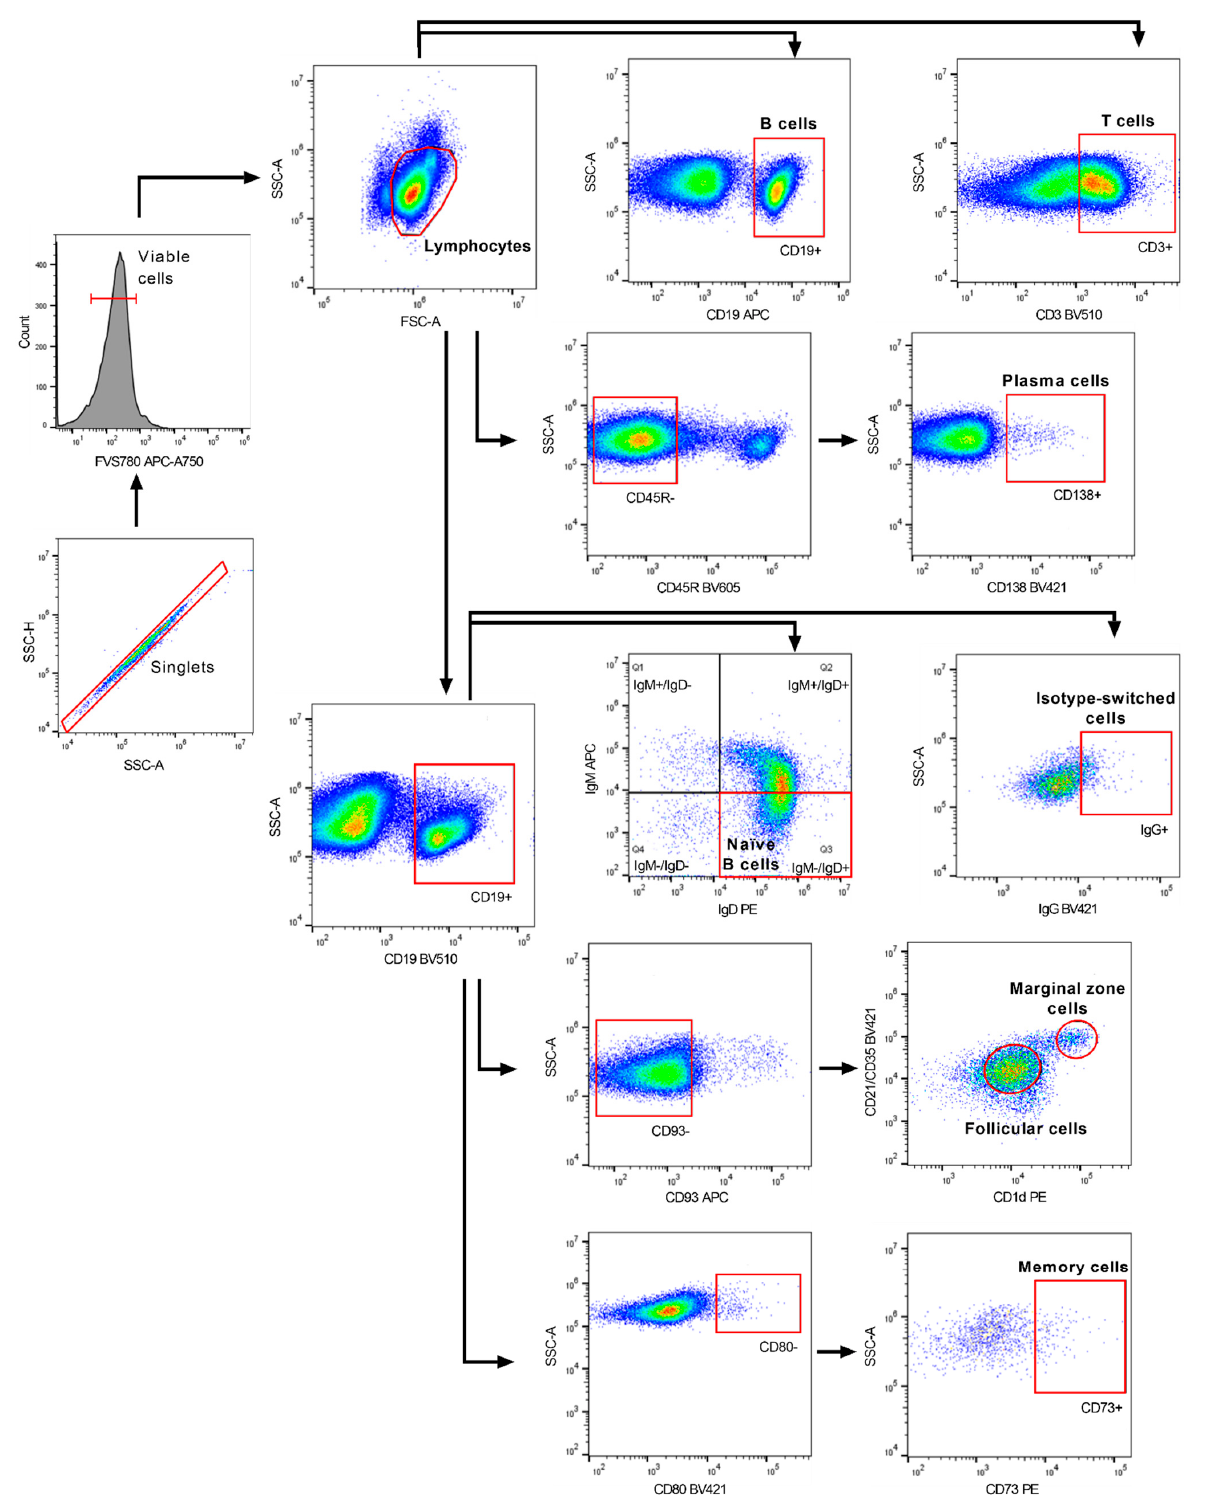
Figure 8. Representative flow cytometric gating strategy for the analysis of B cell subsets. Cells were gated on single live lymphocytes followed by the identification of the different B cell subsets using five separate antibody panels.